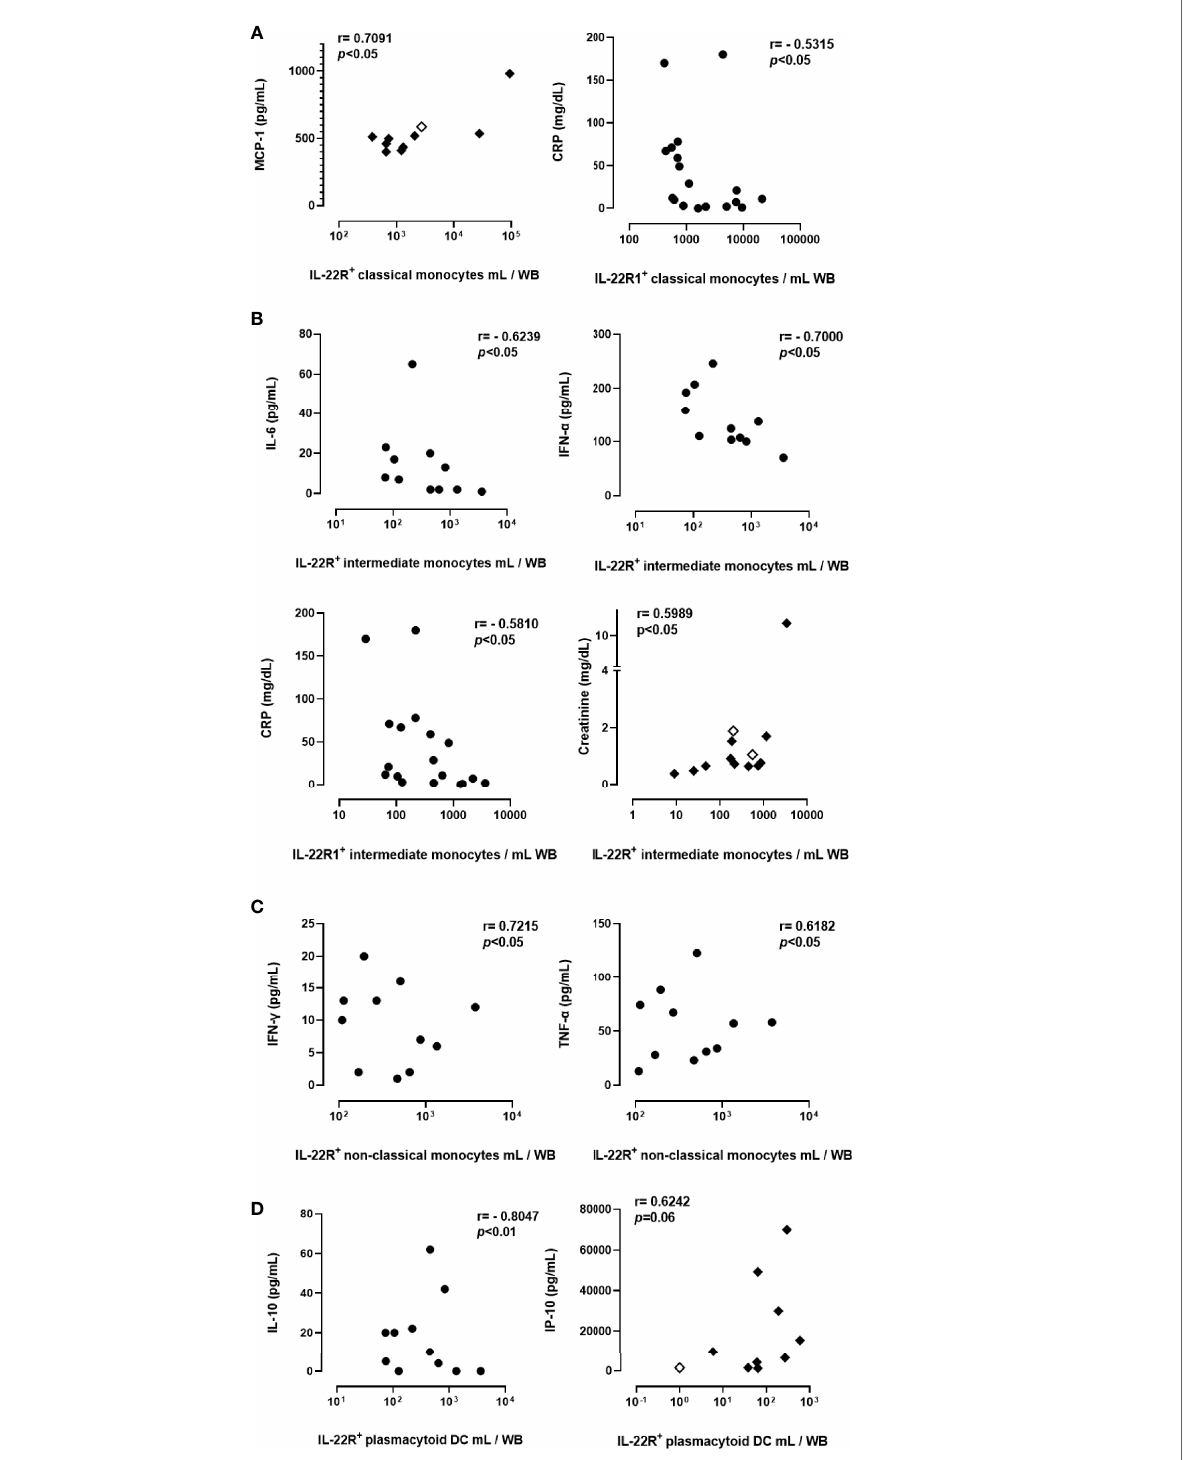
FIGURE 6 | Correlations between the numbers of IL-22R1 + myeloid cell subsets and blood parameters in COVID-19 patients. Only the signi fi cant results are represented on the fi gure for correlations of IL-22R1 expressing classical monocytes (A) , intermediate monocytes (B) , non-classical monocytes (C) and plasmacytoid DC (D) with plasma pro-in fl ammatory mediators. Circles and fi lled diamonds represent non-severe and severe COVID-19 patients, respectively. The empty diamonds were used for patients who died from COVID-19. R and p values obtained by non-parametric Spearman ’ s test are indicated on the